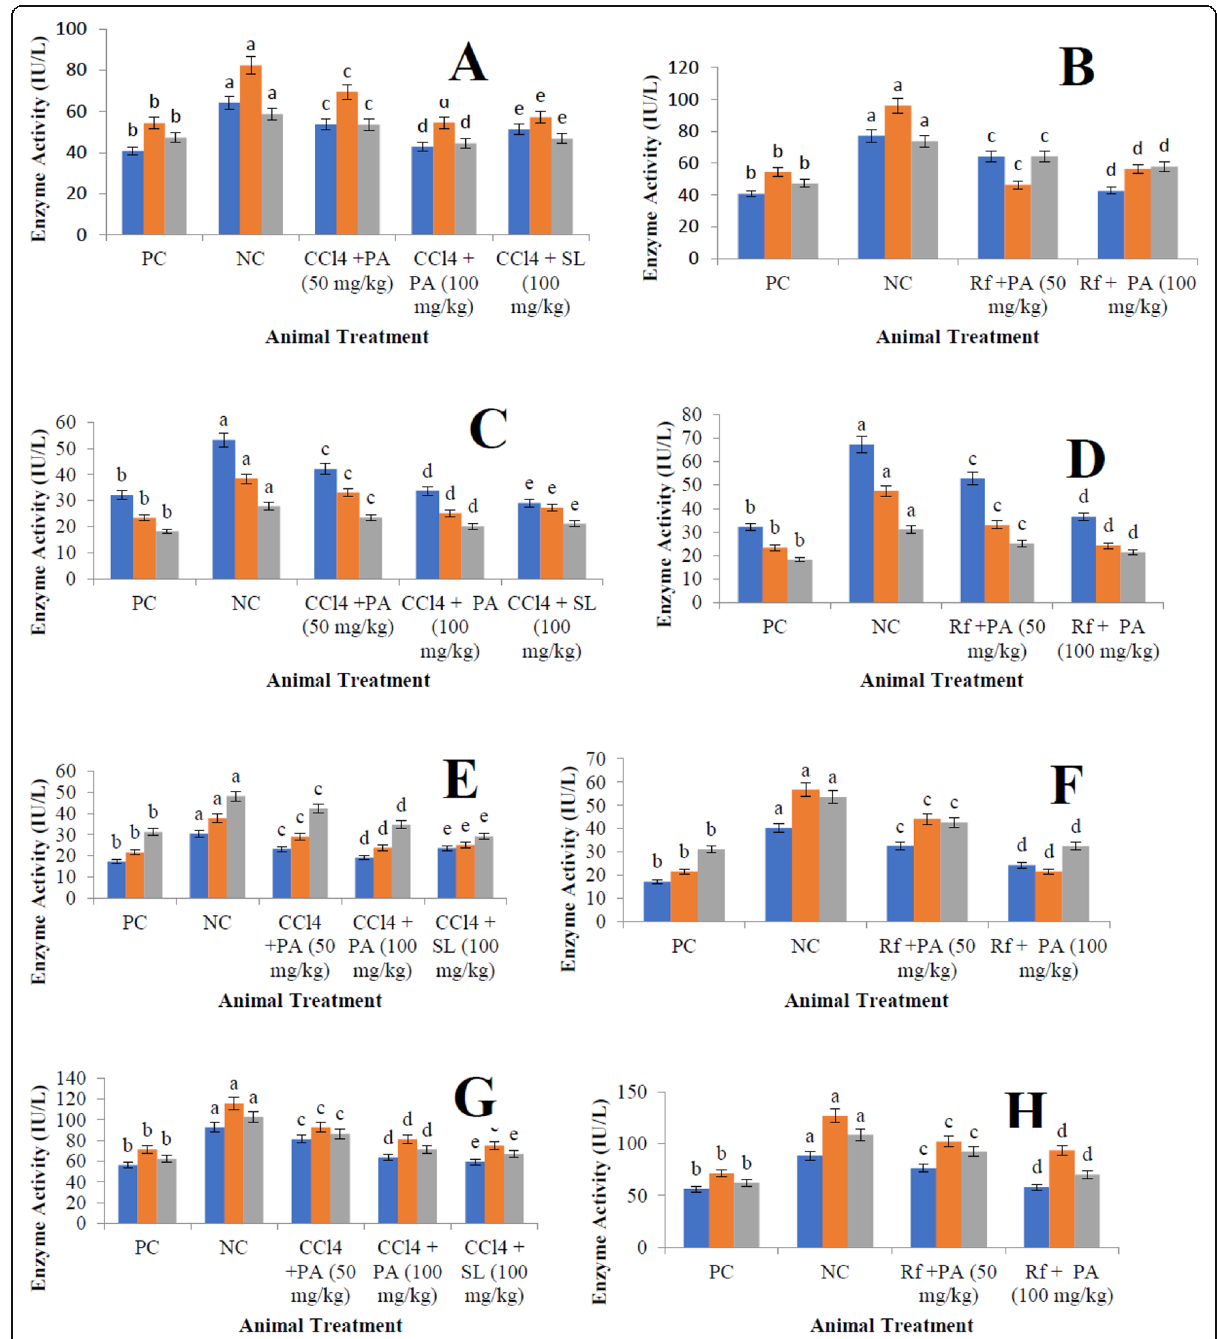
Fig. 2 Effect of P americana leaf extract on selected biomarkers of albino rats exposed to CCl 4 and rifampicin toxicity. Data shows mean ± SEM values of four independent experiments performed in tripilicate. ‘ b ’ , ‘ c ’ , ‘ d ’ and ‘ e ’ represent significant difference ( p < 0.05) from ( ‘ a ’ ) - the positive control (NC); PC- negative control; PA- Pearse americana ; SL- Silymarin. Rf- Rifampicin. ALP- AST- ALT- a and b are liver of CCl 4 and rifampicin- challenged rats respectively. c and d are heart of CCl 4 and rifampicin-challenged rats respectively; e and f are kidney of CCl 4 and rifampicin-challenged rats respectively; g and h are serum of CCl 4 and rifampicin challenged rats